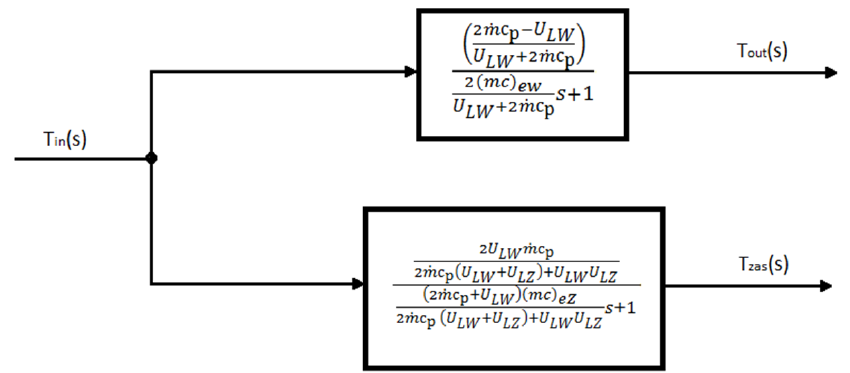
Figure 4. Approximate block diagram of the storage tank model. The U LW and U LZ coefficients in the individual transfer functions of the paths of the model parts correspond to the heat loss coefficients. The U LW coefficient corresponds to the heat losses of the coil heat exchanger and the U LZ coefficient corresponds to the heat losses of the storage tank. The energy balance shows that the power supplied by the heat exchanger should be equal to the power transferred to the storage tank. Therefore, the gain factors of both paths of the operational model of the D HW storage tank should be 1. The heat losses from the coil heat exchanger— U LW should be calculated with Equation (26). The power losses of the tank— U LZ should be calculated with Equation (28), and the thermal capacity of the tank with Equation (29). The heat transfer intensity of the heat